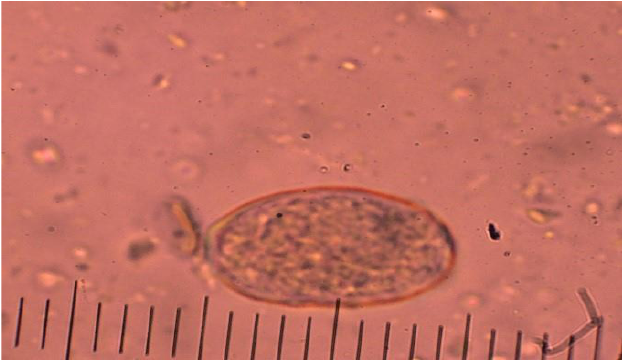
Figure 1. Non sporulated Eimeria crandalis oocyst is seen using the method of floatation with Sheather's solution (40×)